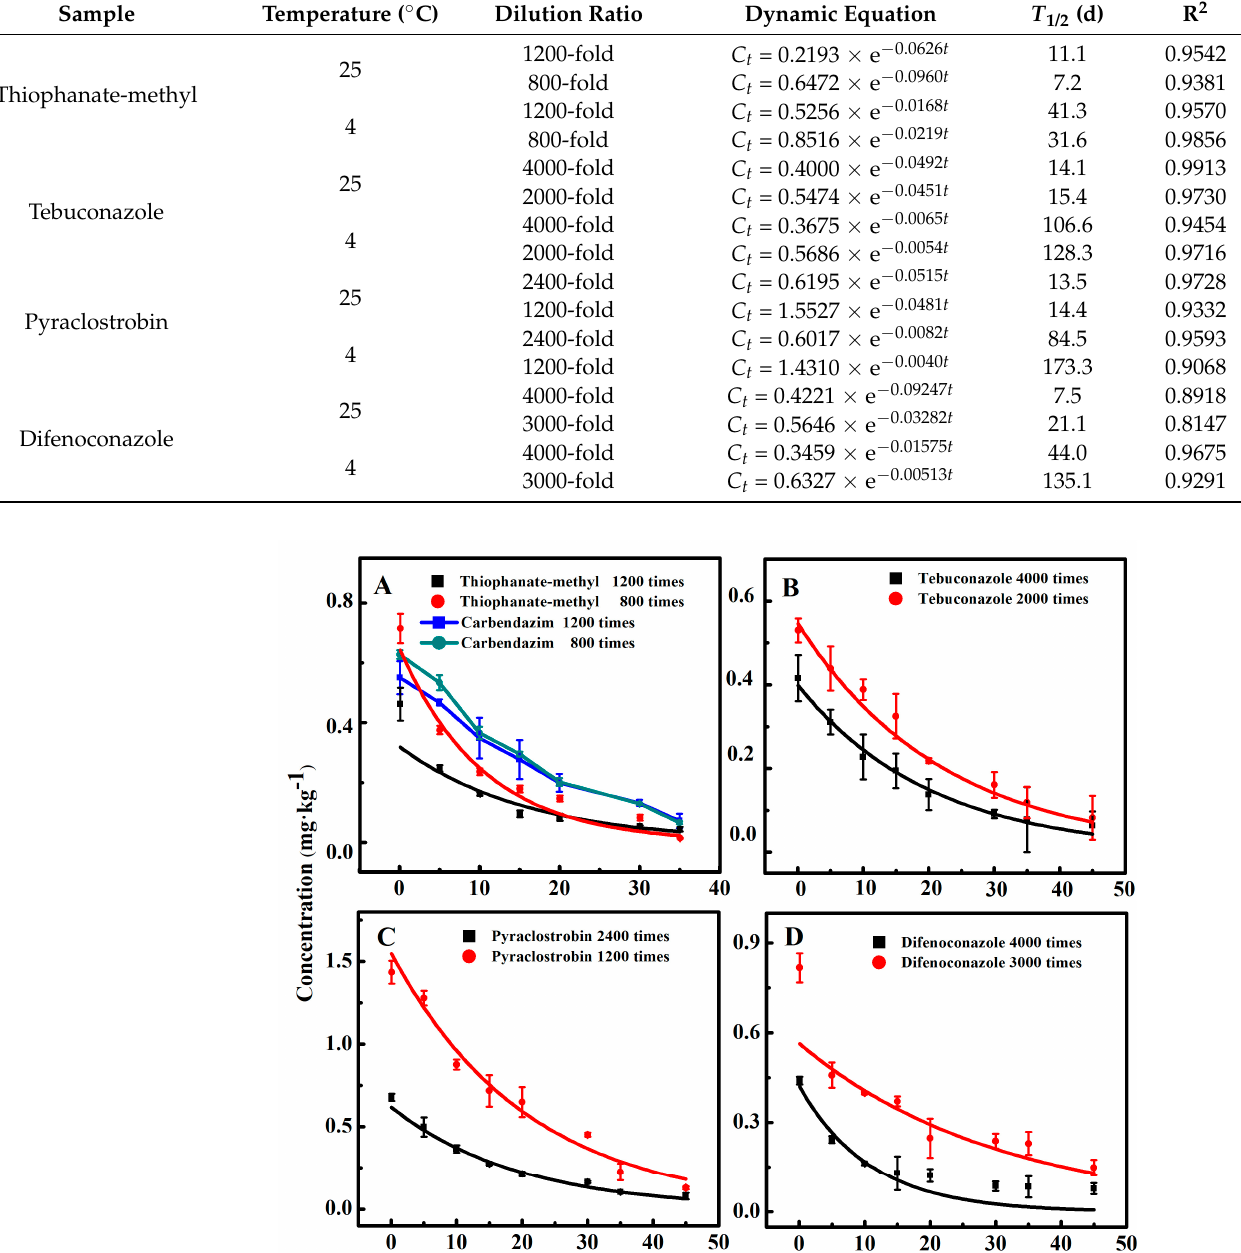
Table 2. Dissipation dynamic parameters of four fungicides and half-lives ( T 1/2 ) of the fungicides in pears at 25 ◦ C and 4 ◦ C storage conditions at two application dosages.